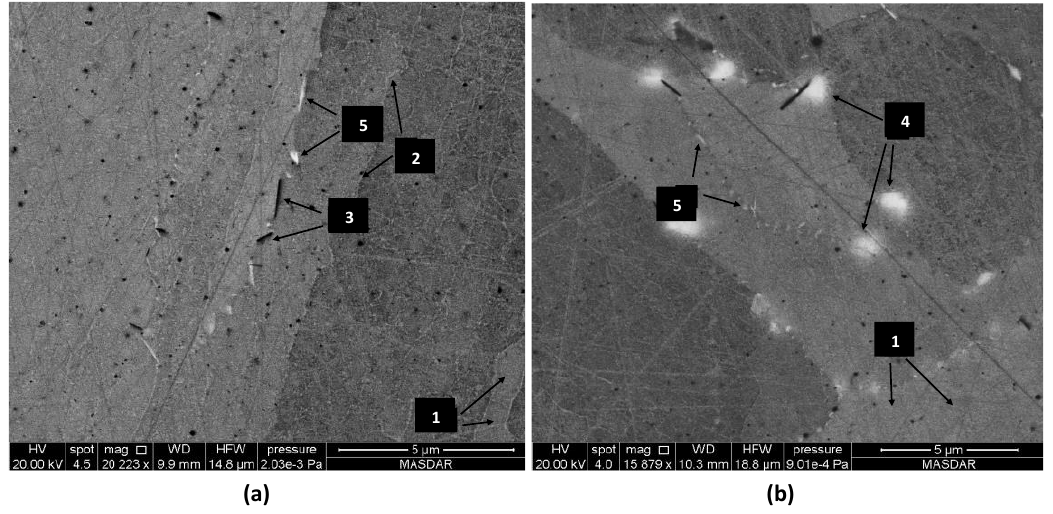
Figure 6. SEM images of homogenized SLM Inconel 718 showing phases 𝛾 , 𝛾 ′′ , δ, MC-carbide, and Laves phases labeled 1–5, respectively. Images ( a , b ) were both taken from the bottom horizontal cross-section.